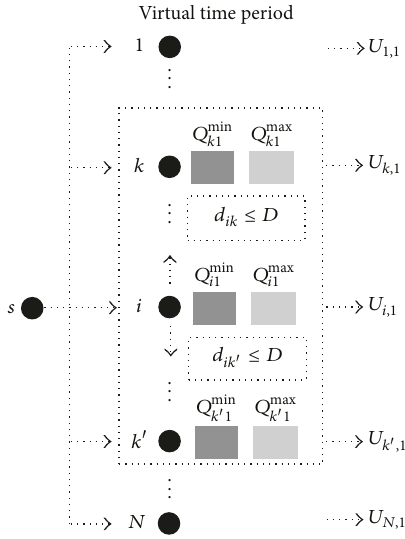
Figure 2: Dynamic working network for virtual time